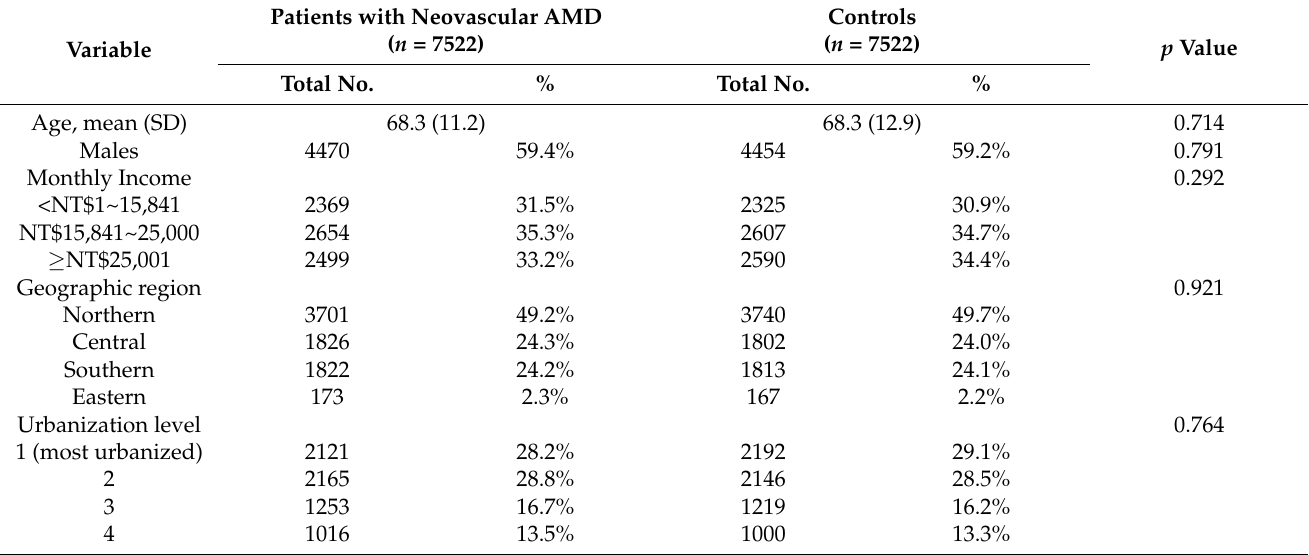
Table 1. Demographic characteristics of persons with neovascular age-related macular degeneration (AMD) and control patients ( n =